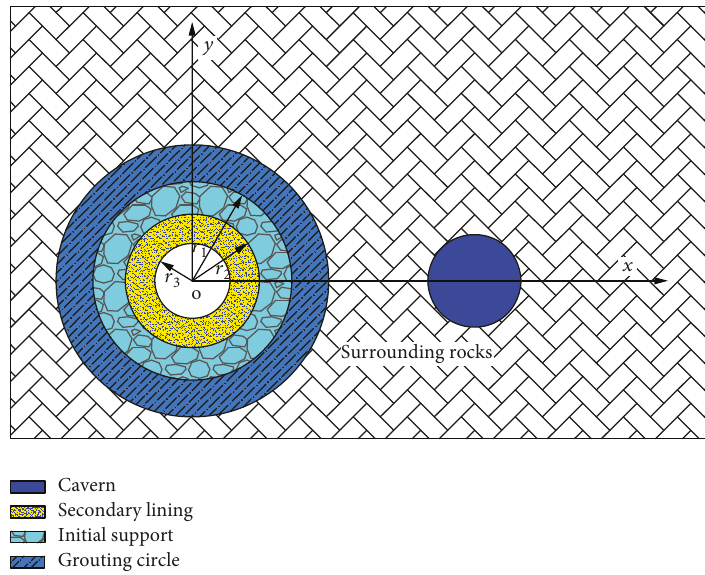
Figure 3: The relationships between each lining